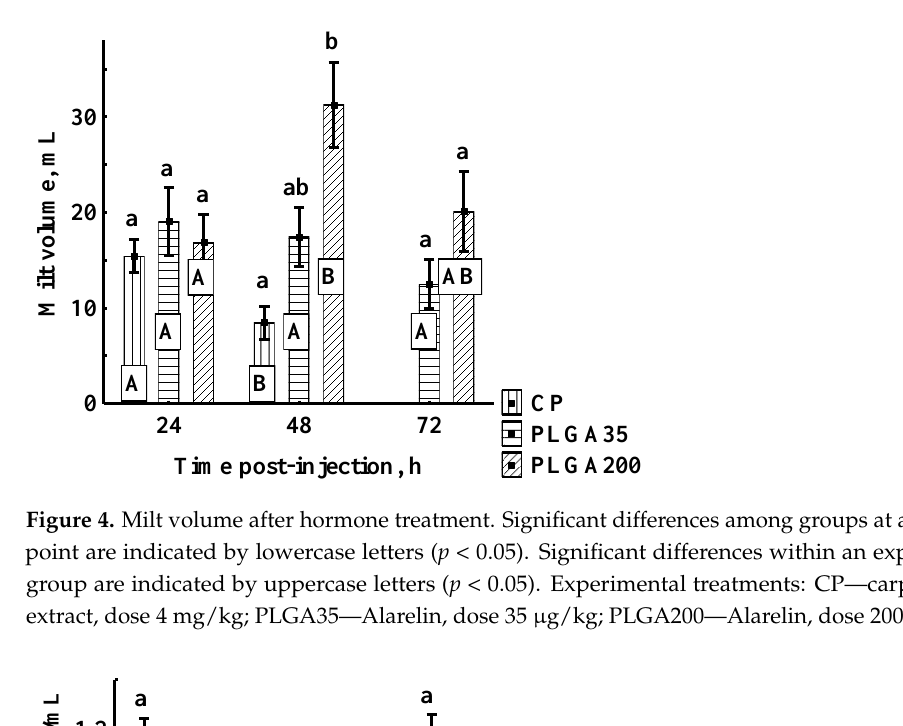
Figure 4. Milt volume after hormone treatment. Significant differences among groups at a sampling point are indicated by lowercase letters ( p < 0.05). Significant differences within an experimental group are indicated by uppercase letters ( p < 0.05). Experimental treatments: CP — carp pituitary extract, dose 4 mg/kg; PLGA35 — Alarelin, dose 35 µg/kg; PLGA200 — Alarelin, dose 200 µg/kg.